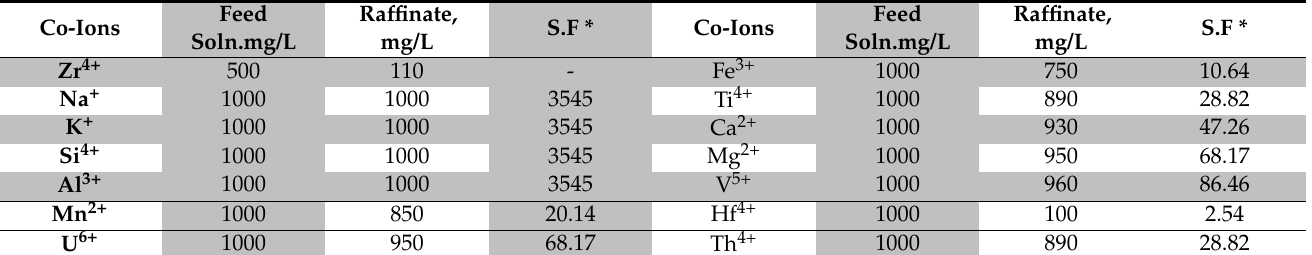
Table 3. The effect of co-ions on zirconium ions extraction efficiency using PPVP. (Conditions: V: